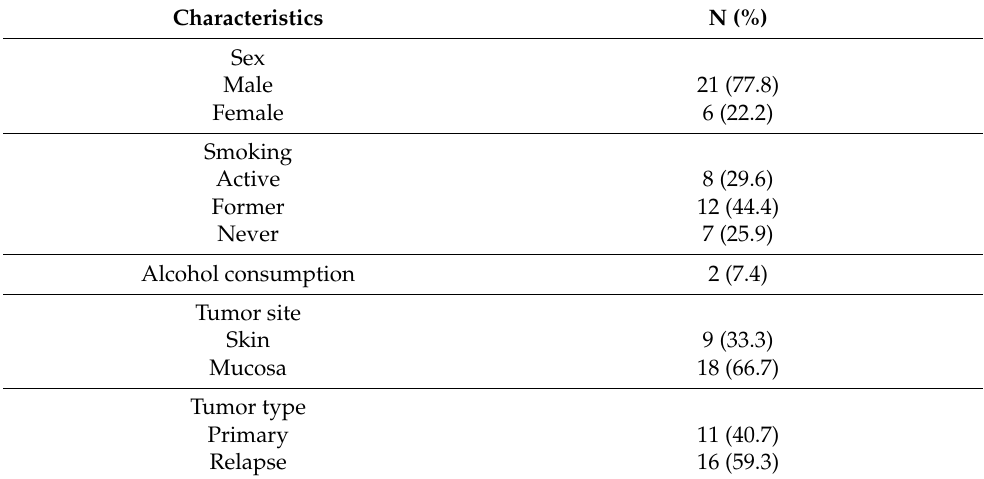
Table 1. Patients and tumors characteristics (27 subjects).